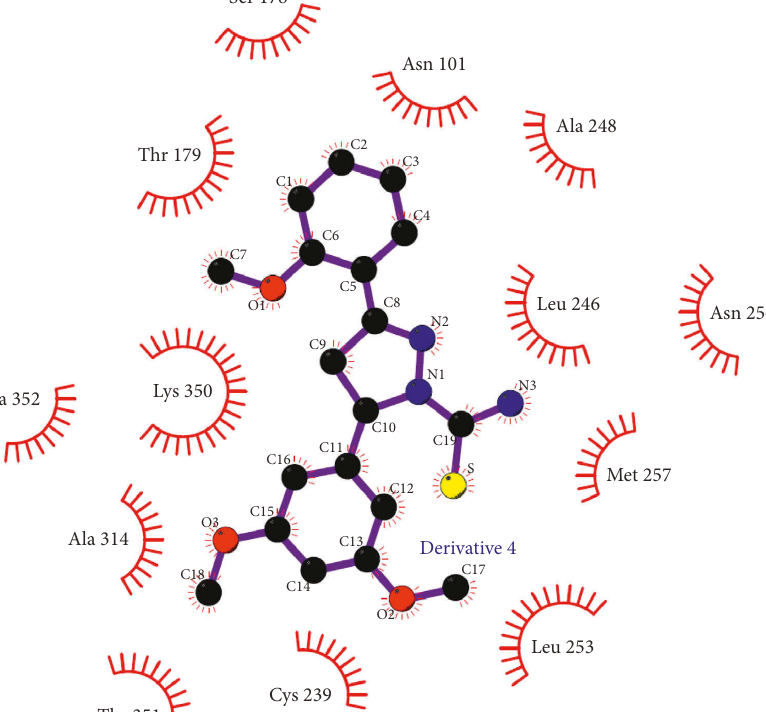
Figure 8: Interactions between derivative 4 and residues of the holoprotein of 6xer.pdb analyzed using LIGPLOT. All residues in the red half-circles denote hydrophobic